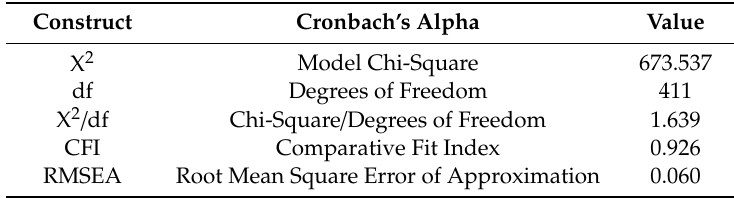
Table 6. Model Fit